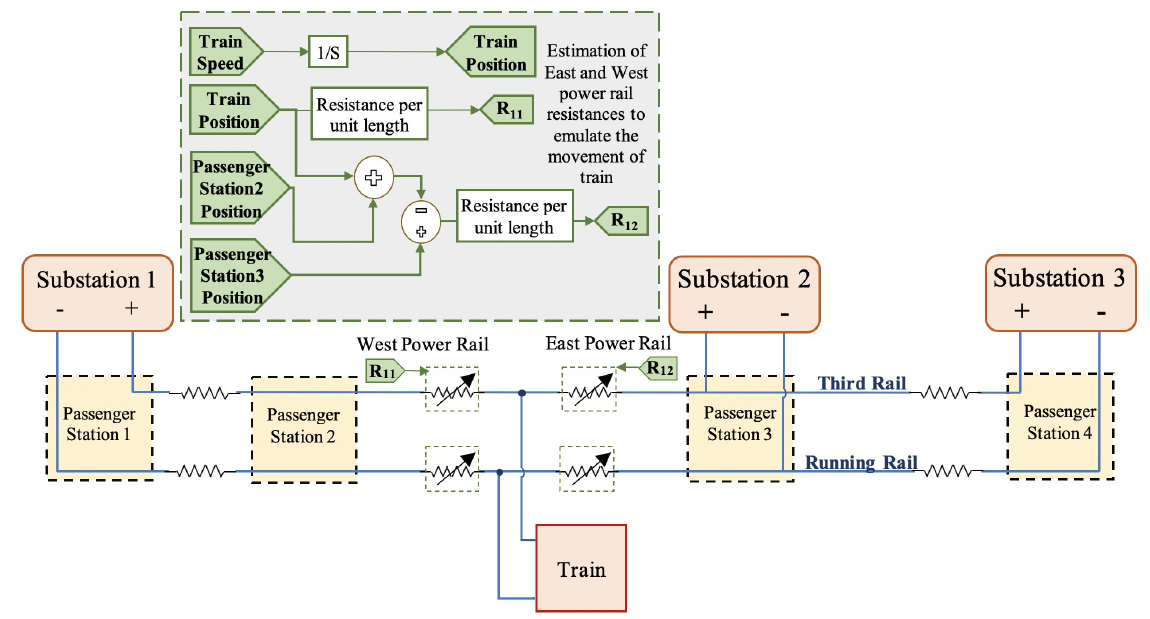
Figure 5. Simulation model of the rail network and locomotion of the